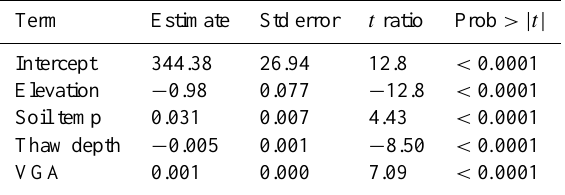
Table 2. Best fit model of CH 4 flux across the site. Listed en- vironmental variables explain 73% of the variance in CH 4 flux ( R 2 = 0 . 73, F 4 , 391 = 267 . 1, p < 0 . 0001).